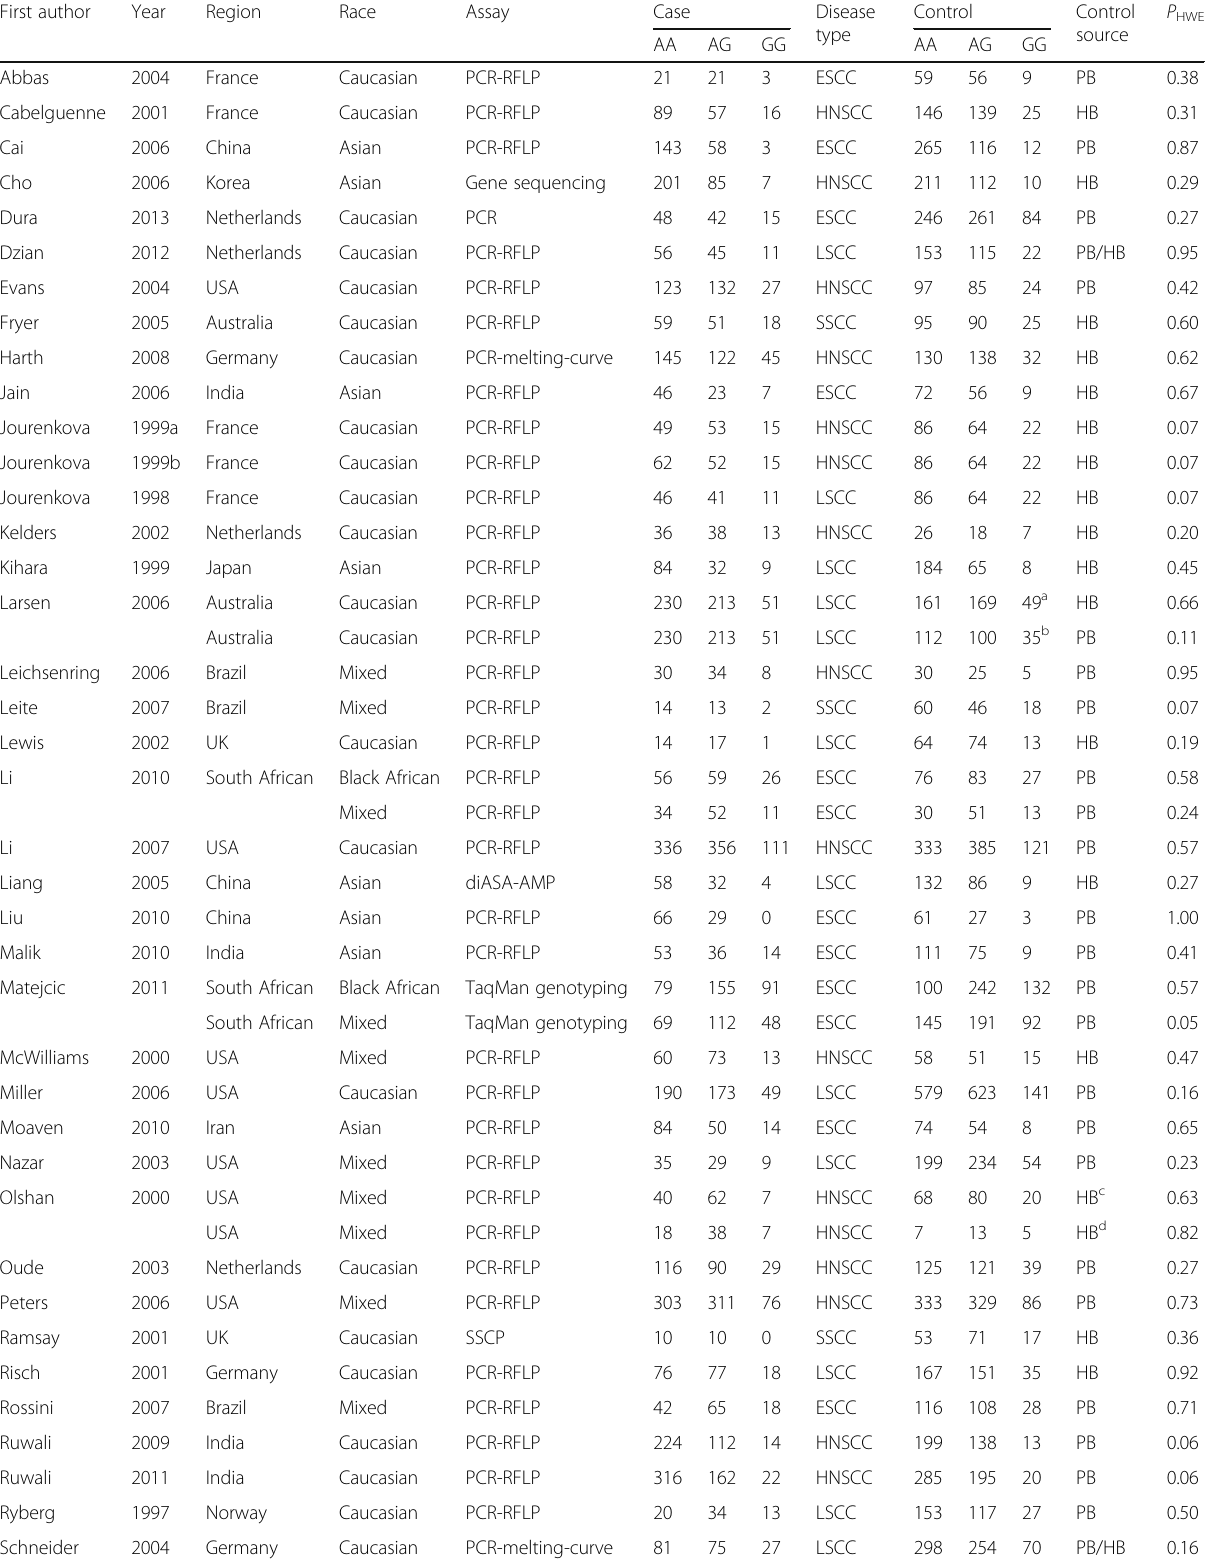
Table 1 Basic information of the eligible articles in the